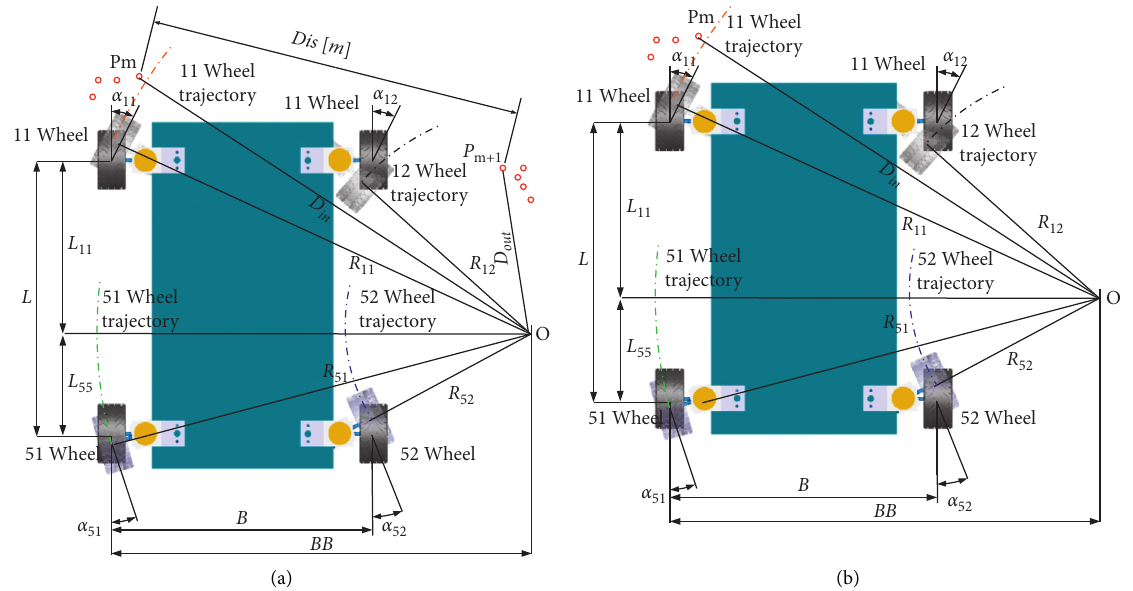
P m and m + 1 . (b) The gap has only one